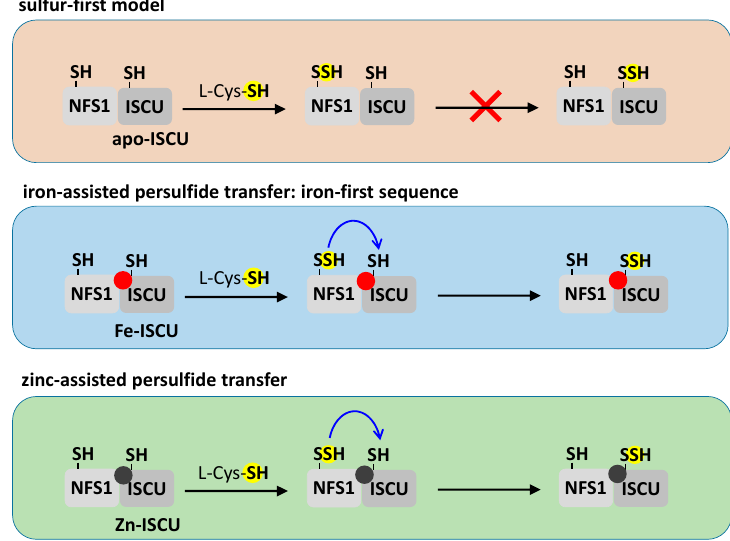
Figure 5. Metal-dependent persulfide transfer in the NFS1–ISCU complex. The sequence corresponding to the sulfur-first and iron-first models are depicted in the top two panels. First, a persulfide is formed on the catalytic cysteine of NFS1 (Cys381). Then, in the absence of a metal in ISCU (apo-ISCU), the persulfide of NFS1 is not transferred to ISCU (as shown by the red cross), which invalidates the sulfur-first model. In the presence of iron (red sphere, Fe–ISCU), the persulfide of NFS1 is transferred to the cysteine Cys104 of ISCU, which highlights the iron-first model. The third panel shows that, when zinc (dark gray sphere, Zn–ISCU) is present in the assembly site, instead of iron, it also triggers persulfide transfer. The blue arrows refer to movement of sulfur in trans-persulfuration reactions.